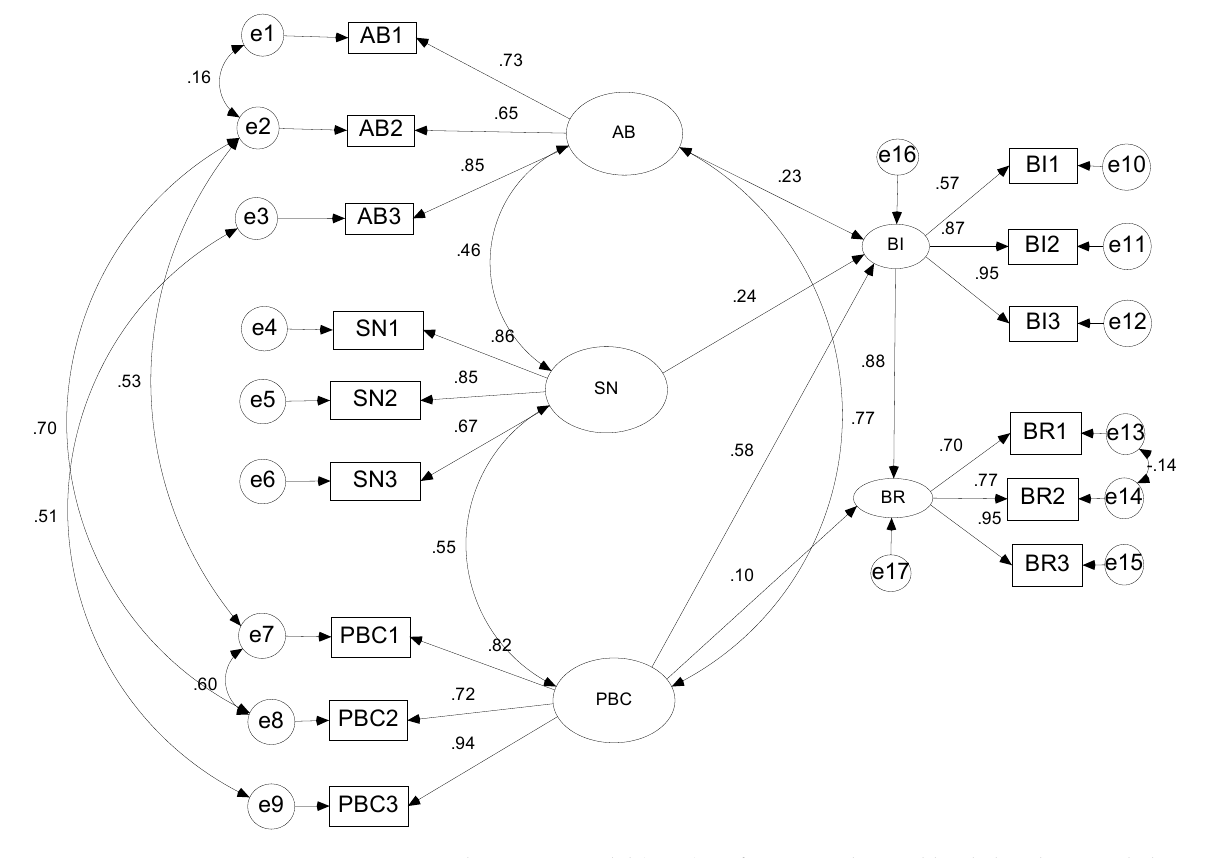
Figure 6. Structural equation model (SEM) on farmers’ cultivated land abandonment behavior and its estimation results (Note: → denotes causality among latent variables, from dependent variable to result variable; ↔ denotes correlation among latent variables; e1–e17 denote the residual error of the observation variables in the measurement model and the measurement error in structural model.). Table 5. Key performance indices of model.